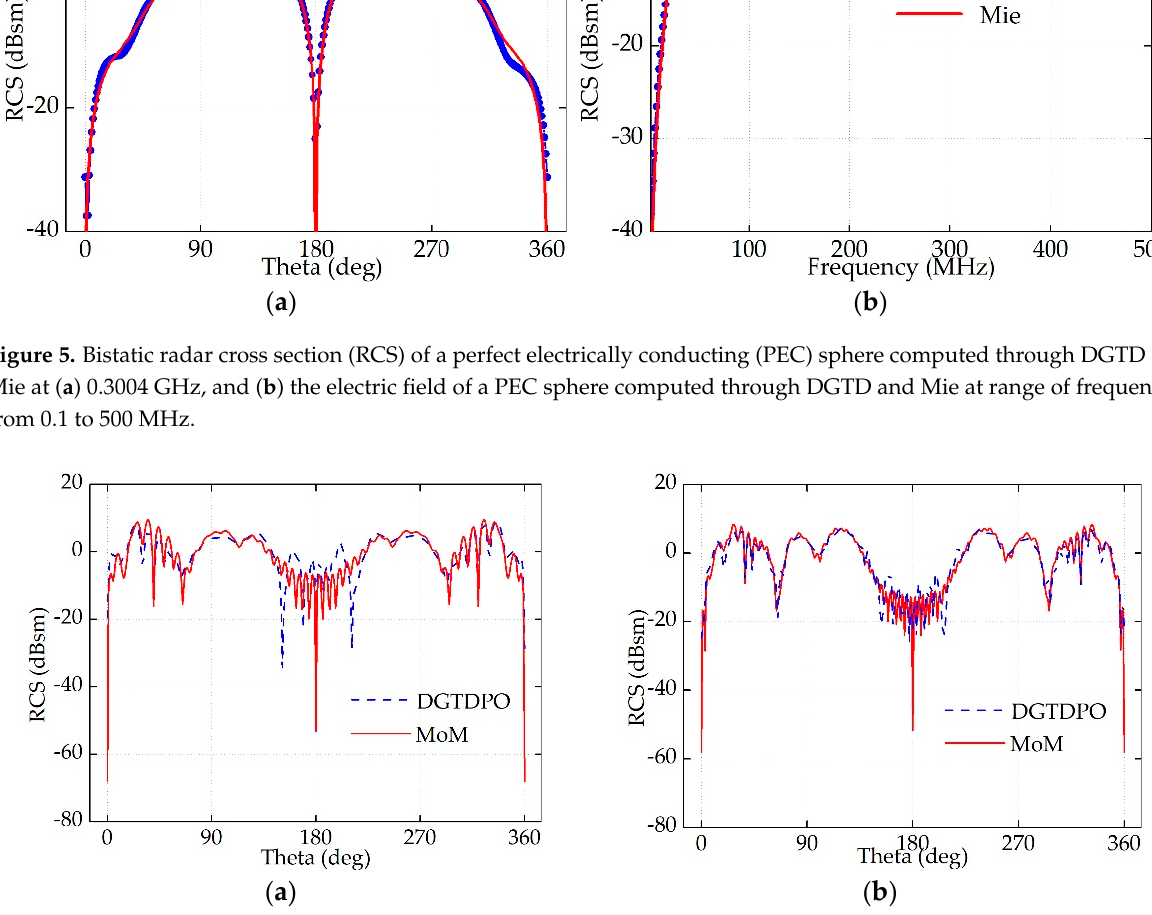
Figure 6. The RCS of a PEC sphere-plate computed at ( a ) 0.3004 GHz and ( b ) 0.5 GHz from the solutions of the DGTDPO method and Method of Moment (MoM).